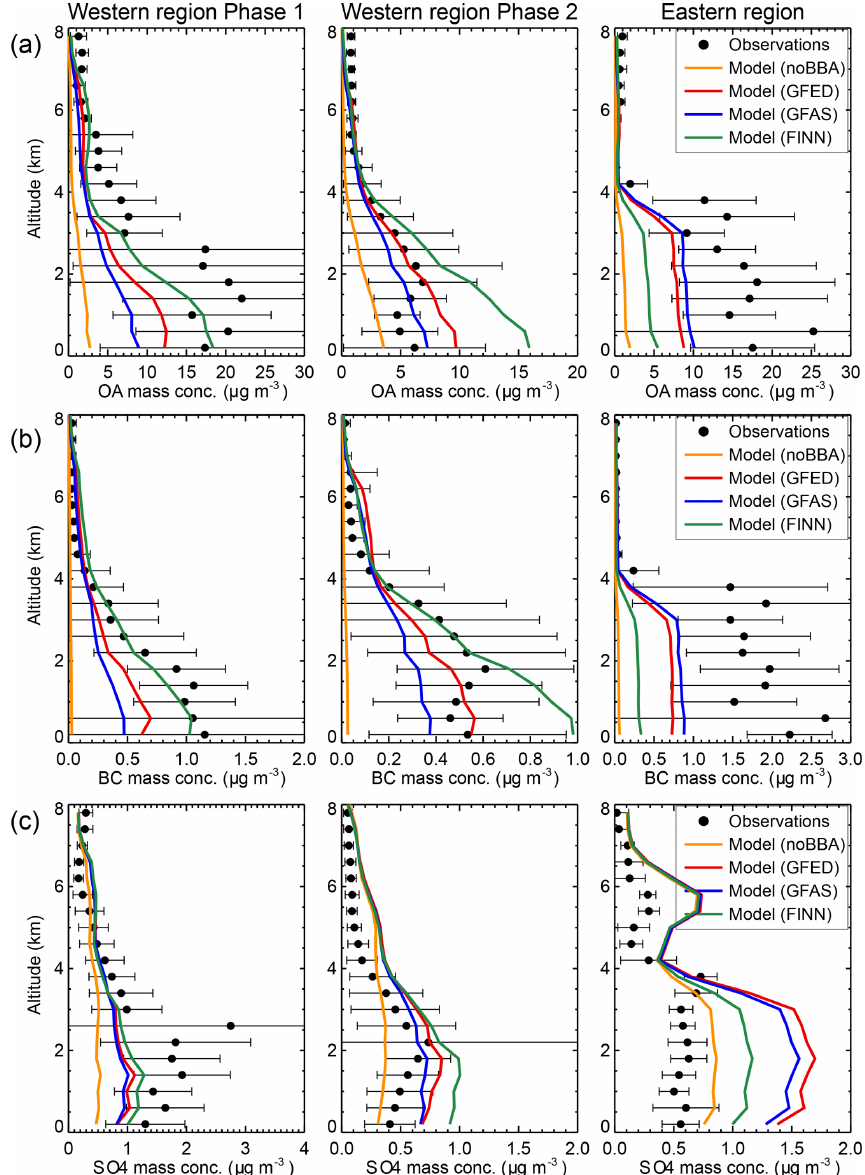
Figure 5. Mean observed and simulated vertical profiles of (a) organic aerosol (OA), (b) black carbon (BC) and (c) sulfate (SO 4 ) during the SAMBBA aircraft campaign, sectioned into 400m altitude bins. Observations are shown by the black data points. Simulated concentrations are shown for the model with FINN1.5 (green), GFAS1.2 (blue), GFED4 (red) emissions and with no biomass burning emissions (noBBA; orange). The simulated data (linearly interpolated to the flight track of the aircraft) and the observations are split into western and eastern regions of the Amazon (Fig. 2), as well as by time (Phase 1: 13–22 September 2012; Phase 2: 23 September–3 October 2012) for the western region. Error bars show the standard deviation of the observed mean. Concentrations are reported at standard temperature and pressure (STP) conditions (at 273.15K and 1013.25hPa). The NMBF values are given separately for the western region (Phase 1 and Phase 2) and eastern region in Table